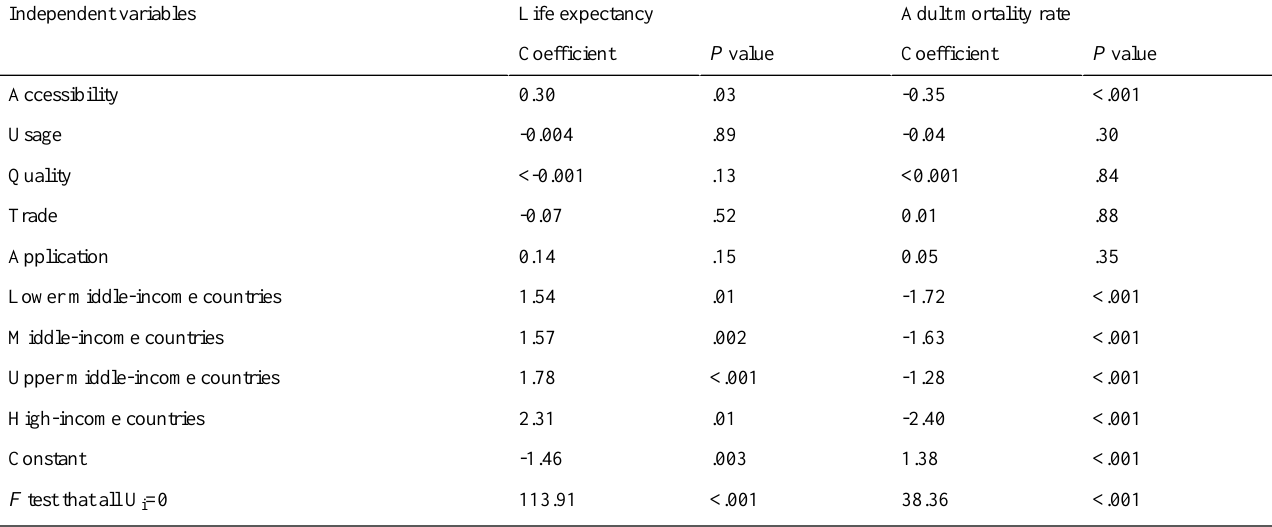
Table 4. Associations between ICT factors and public health delivery indicators (life expectancy, adult mortality